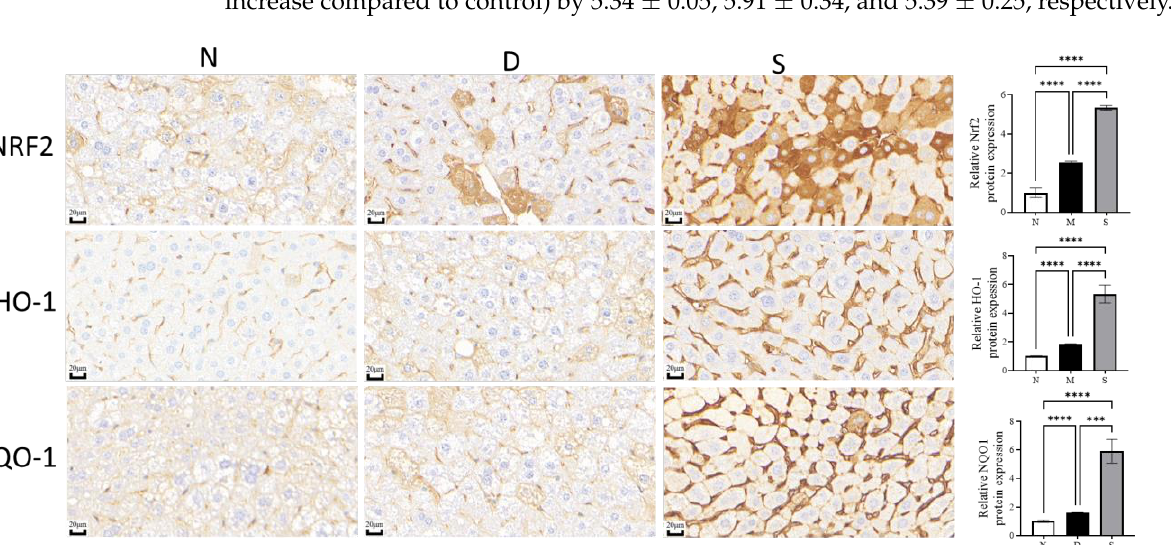
Figure 6. Immunohistochemistry studies of the effect of Swietenine on NRF2, NQO1 and HO-1. N, normal group; D, diabetic mice group; S, treatment with swietenine group (80 mg/kg). In the diabetic group, these proteins were upregulated, whereas the swietenine treatment (80 mg/kg) significantly upregulated the proteins further. ns: Not significant; *** p < 0.001, **** p < 0.0001.